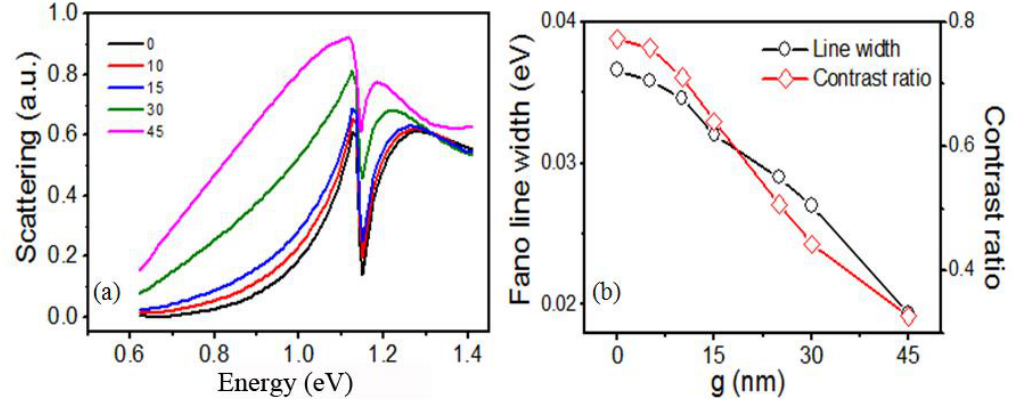
Figure 10. ( a ) The scattering spectra of the RCSRD and ( b ) the Fano linewidth and contrast ratio as a function of the incident angle θ . The geometric parameters are: the gap g = 10 nm, g = 20 nm, and the rod length a = 145 0